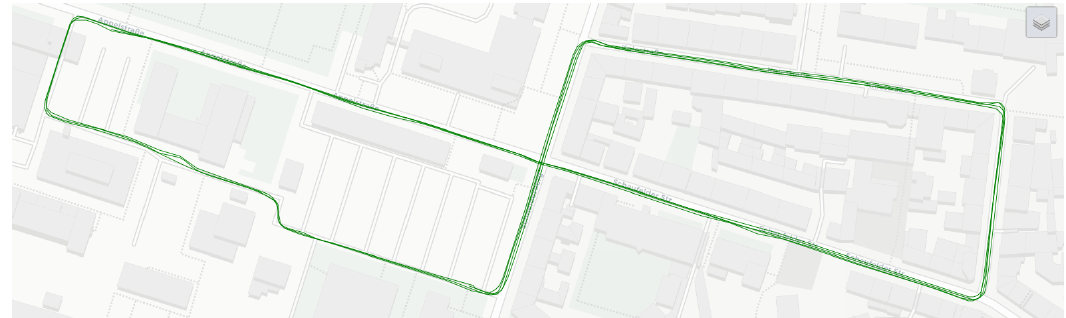
Figure 7. Reference trajectory for IfE van during the first Meet & Greet scenario as obtained by a JAVAD Sigma